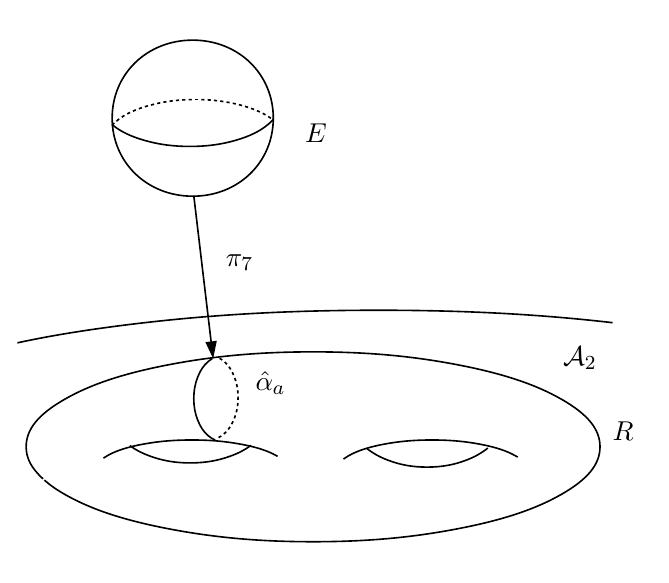
Figure 2 . Fibration structure of D ′ 7 . The Riemann surface R is a hypersurface of the toric space 2 over which the toric surface E is A